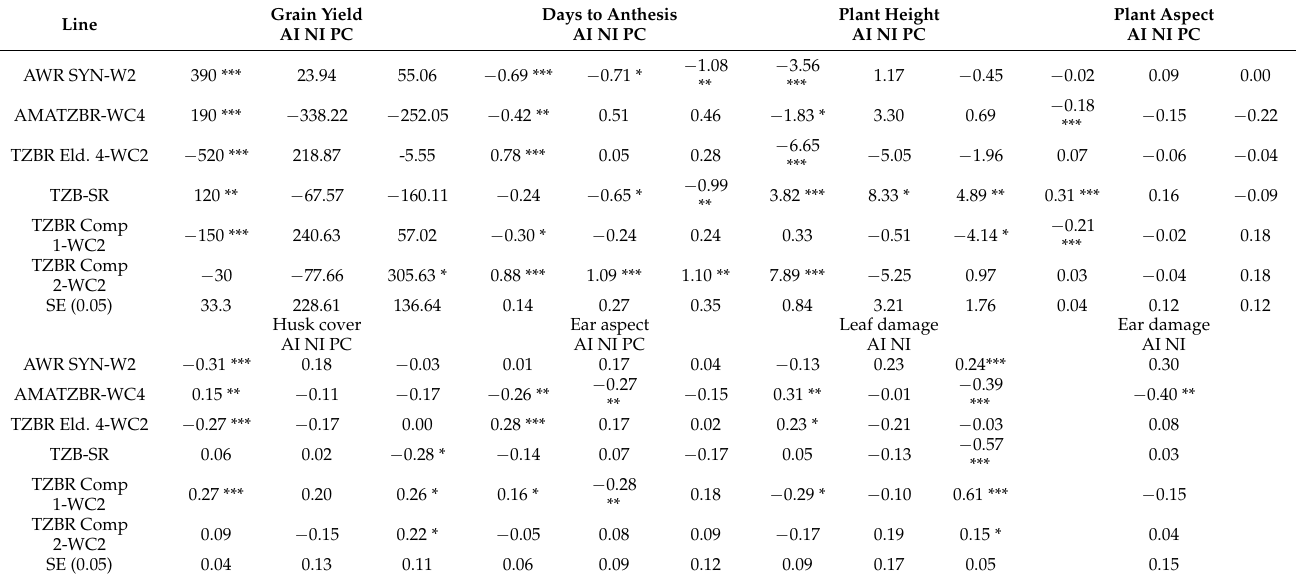
Table 5. General combining ability effect of lines for grain yield, agronomic and fall armyworm (FAW)-resistant traits under FAW infestation and pesticide-protected conditions in Nigeria.